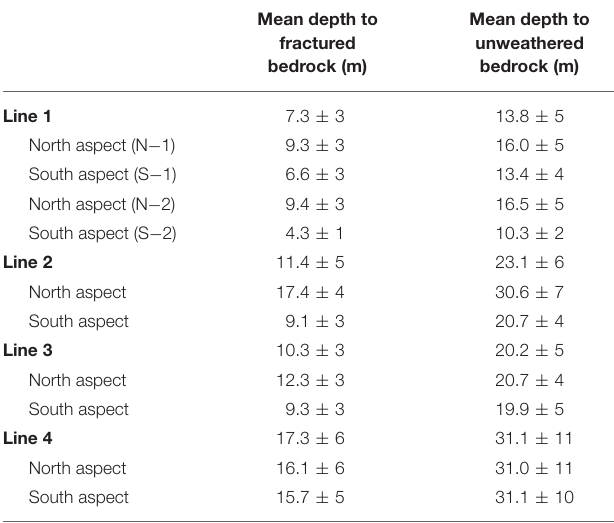
TABLE 1 | P-wave velocities for the weathering stages of granite as measured by Olona et al. (2010).